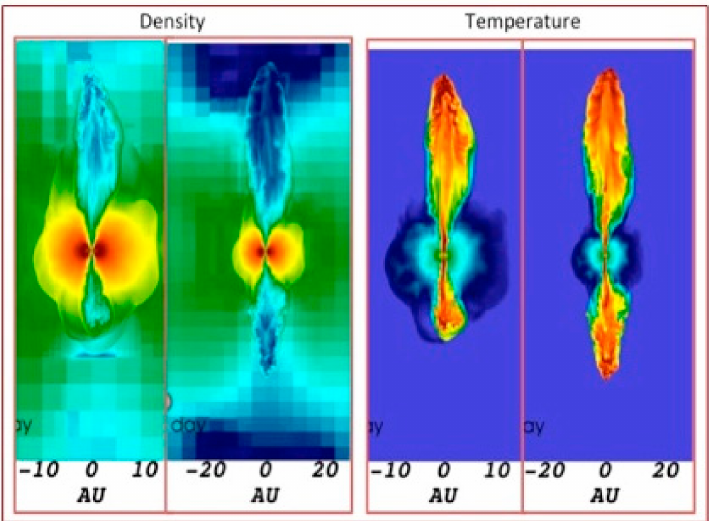
Figure 2. 2-D slices of the X-Z plane of log density ( right ) and log temperature ( left ) from 3-D AMR simulations of a low momentum fast wind being driven into CEE ejecta. We present two different times for the simulations. Each left sub-panel is at t = 6440 days after initiation of fast wind. Each right sub-panel is at t = 6770 days after initiation of fast wind. Note the change of scales between the two times as the nebular lobes